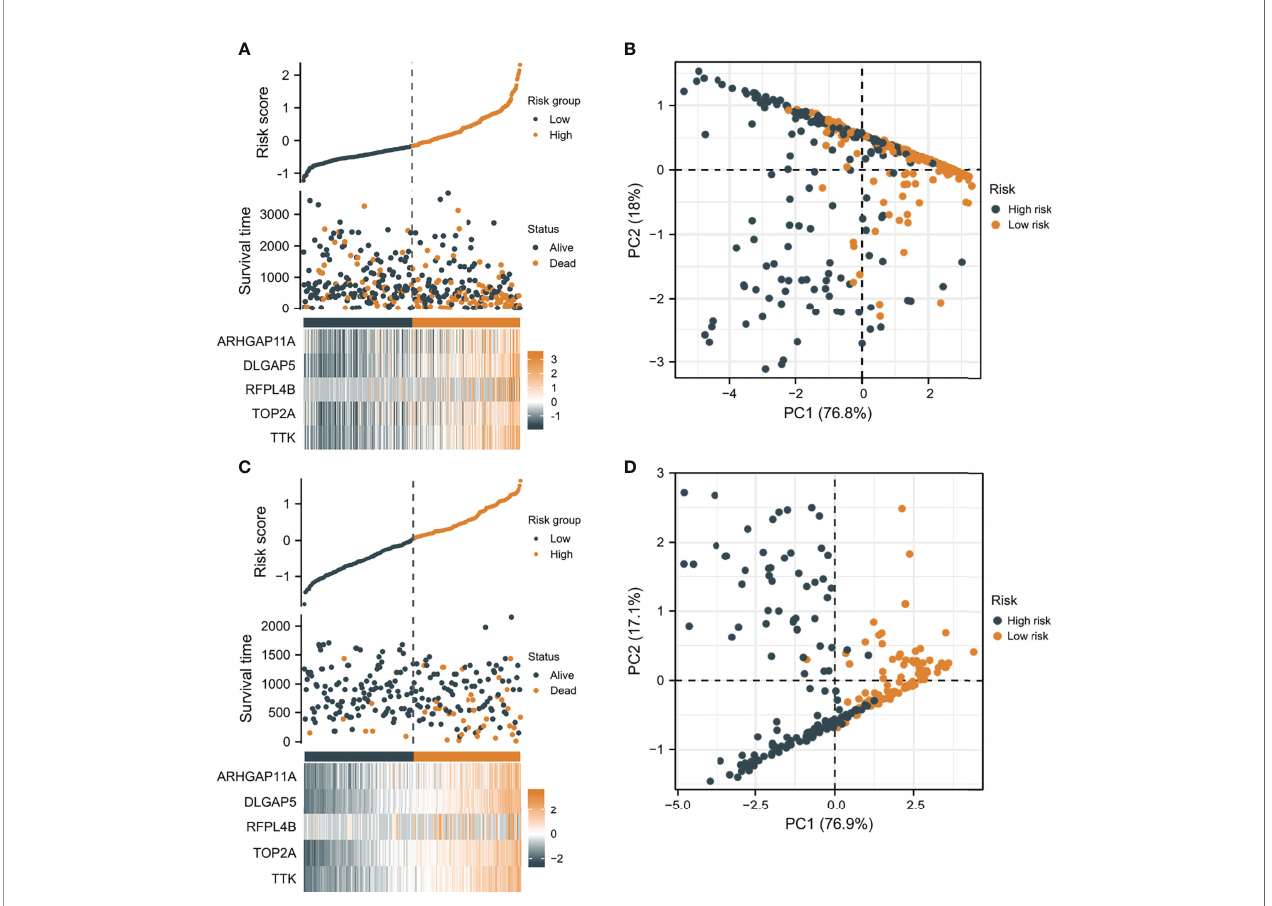
FIGURE 5 | The veri fi cation of the prognostic model ’ s predicting power. (A) The heat map combined with survival status, risk score distribution, and expression difference in the 5 independent prognostic genes in TCGA. (B) PCA based on the 5 independent prognostic genes in TCGA. (C) The heat map combined with survival status, risk score distribution, and expression difference in the 5 independent prognostic genes in ICGC. (D) PCA of the 5 independent prognostic genes in